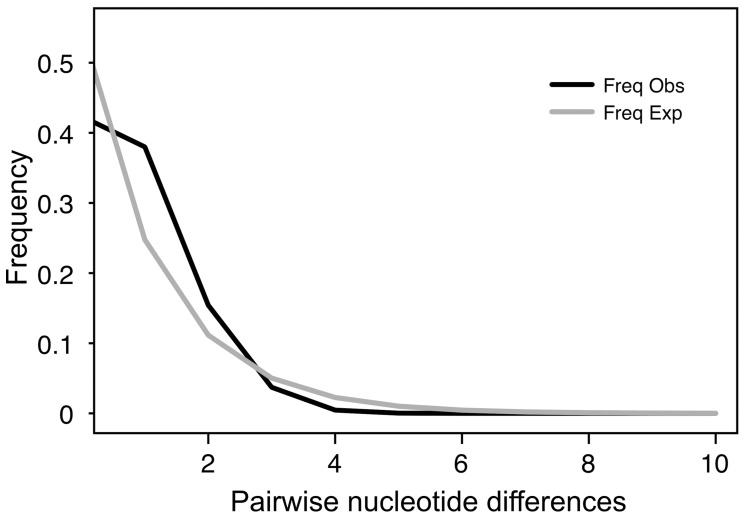
Mismatch distributions of pairwise nucleotide differences between mtDNA haplotypes revealed a unimodal pattern and no significant differences between the observed and expected frequencies (sum of squared deviation = 0.000344, P = 0.75).The black line is the observed frequency and gray line is the expected frequency.